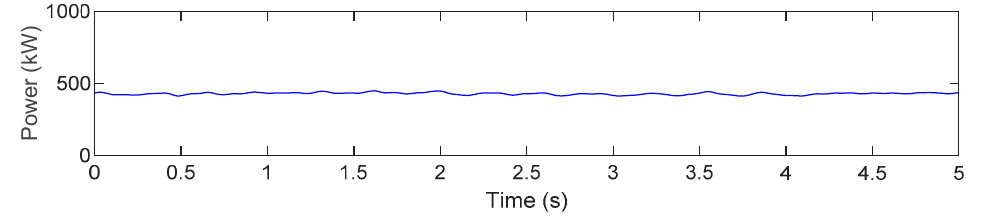
Figure 6. Mechanical characteristic of the LSPMSM SMH-1732T motor: ( a ) static, ( b ) dynamic [38]. After a violent start-up of the motor, the recorded active power becomes stable at 430 kW (70% of the nominal motor power) (Figure 7). As in the case of the SAS motor, the active power was measured for a loaded mill operating at the nominal efficiency of 80 Mg/h. In this case, the fluctuations of the active power in steady motion (Figure 7) are decidedly lower than in the case of the SAS motor (Figure 3).